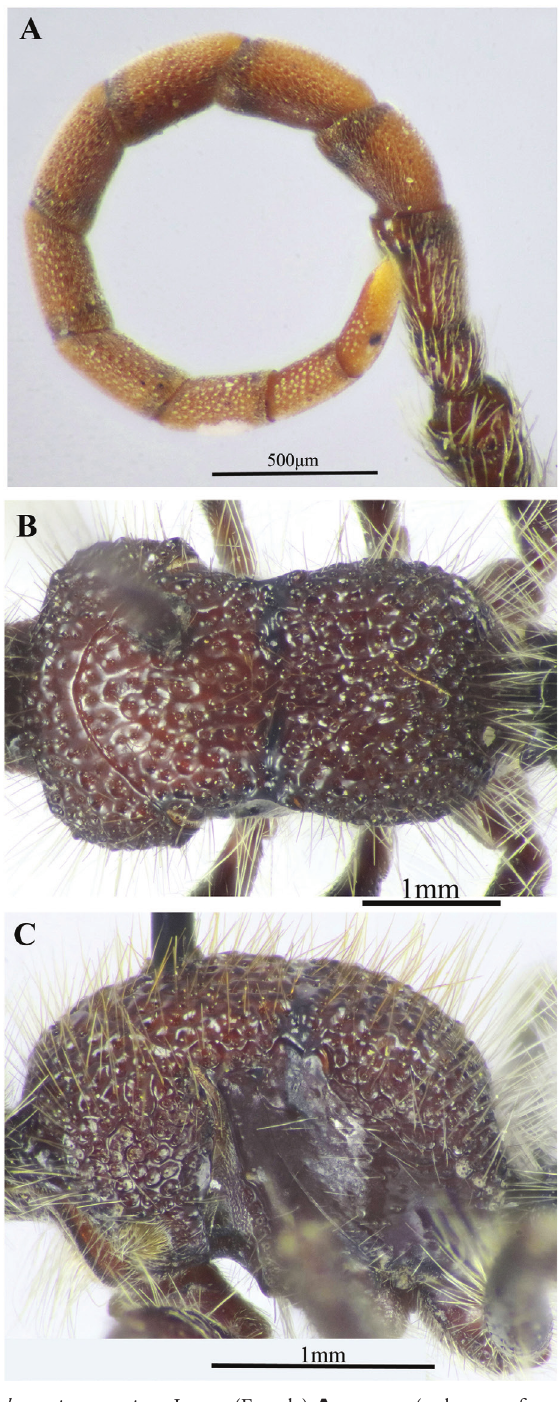
Figure 20. Pseudophotopsis mascatiana Invrea (Female) A antenna (only part of scape) B, C mesosoma, dorsal and lateral views,